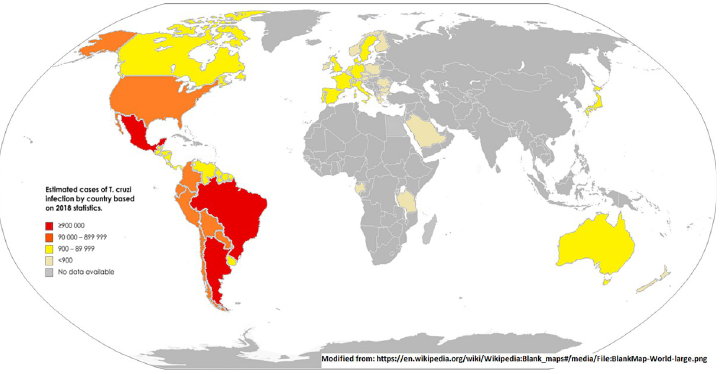
Fig 1. Global epidemiology of Chagas disease. Data from World Health Organization Control of Tropical Neglected Disease. Modified from: https://en.wikipedia.org/wiki/Wikipedia:Blank_maps#/media/File:BlankMap-World-large.